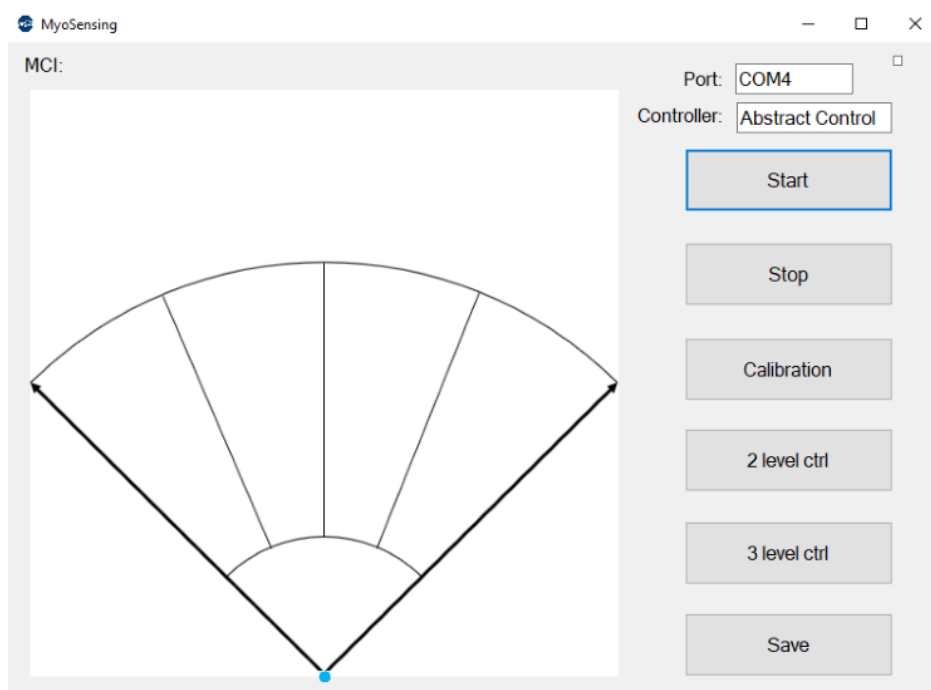
Figure 2. User interface for the proposed